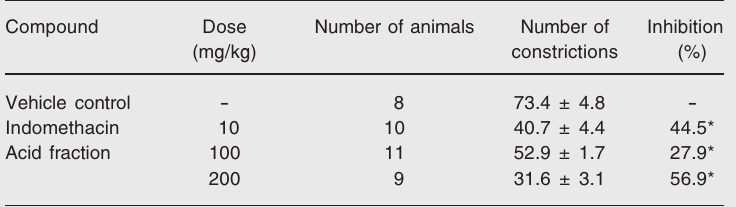
Results are reported as mean ± SEM for the number of constrictions indicated in the table. The seed acid fraction and indomethacin were administered orally and acetic acid (0.6%) was administered intraperitoneally. Inhibition is reported as percent com- pared to the vehicle control Tween/EtOH/H 2 O 2 (2:2:20, v/v/v). *P < 0.05 compared to the vehicle control group (Student t